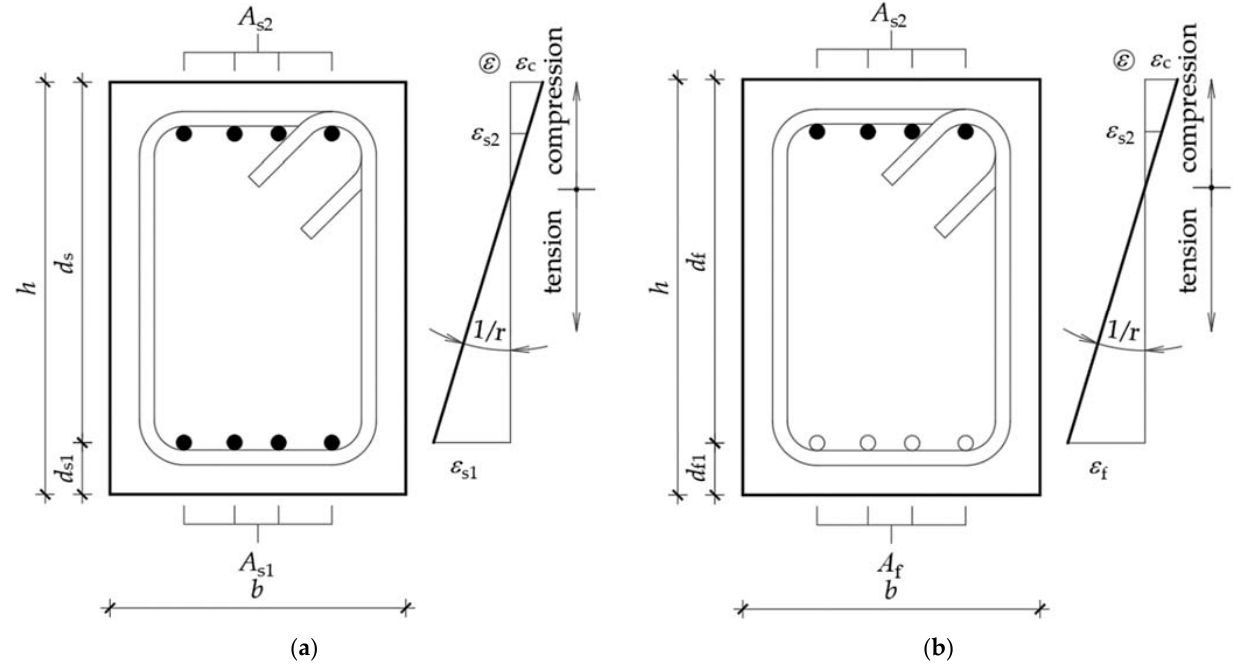
Figure 1. Concrete cross sections with strain diagram: ( a ) Steel reinforced section; ( b ) FRP reinforced section.